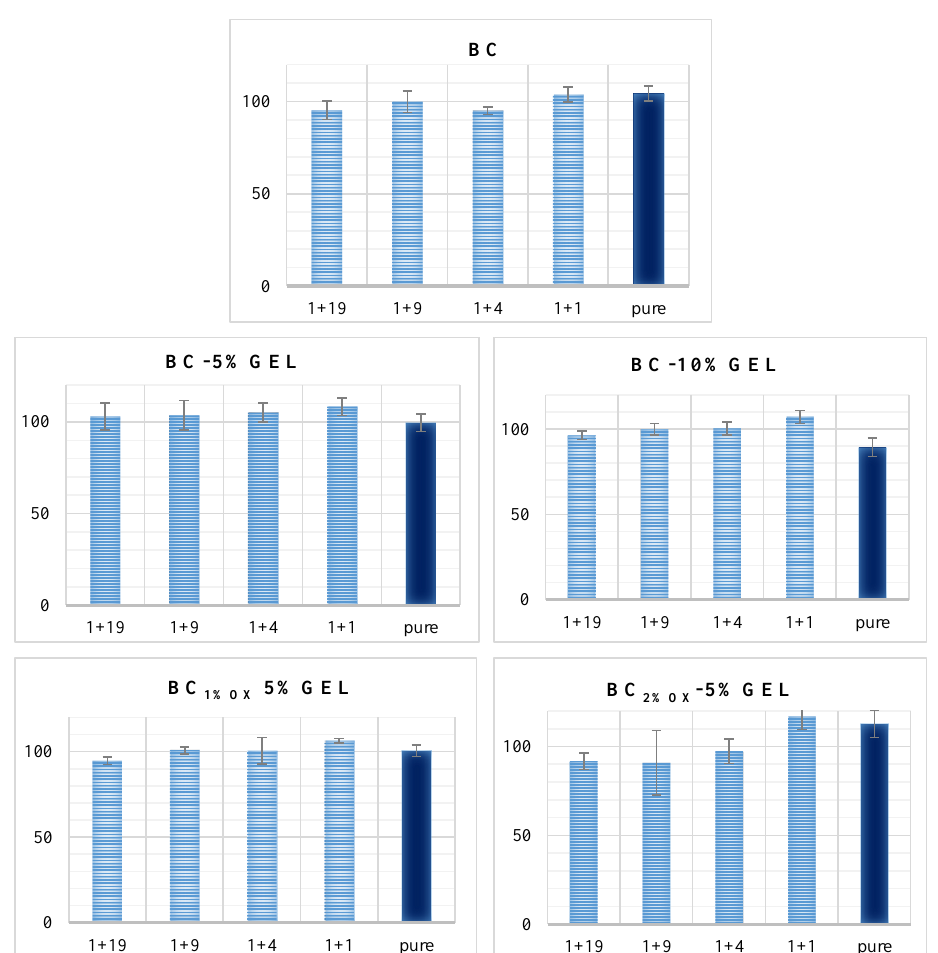
Figure 7. Dehydrogenase activity of MRC-5 cells exposed to eluates of the sample for 72 h. The viability of cells treated with medium was set as 100% ( y axis). Eluate (pure) and different dilutions are presented on the x axis.